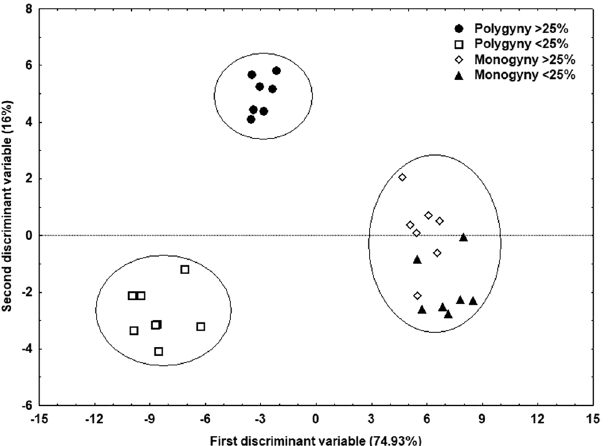
Figure 5. Results of the discriminant analysis conducted on the relative quantities of CHCs in the profiles of high-fecundity queens (> 25%) (n = 7) and low-fecundity queens (< 25%) (n = 8) under polygynous and monogynous conditions.